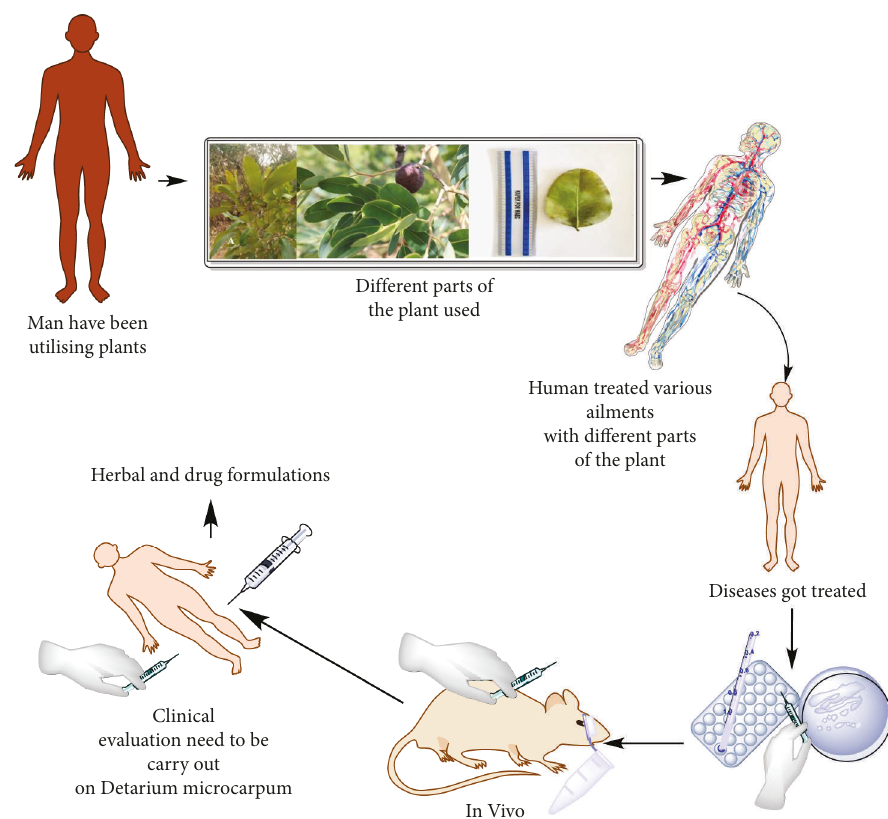
Figure 3: Diagrammatic presentation of how man utilises plants leads to the development of modern drugs and herbal